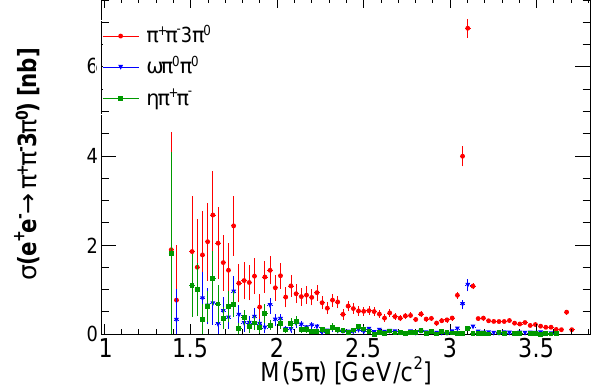
5 e + e − → π + π − 3 π 0 cross section